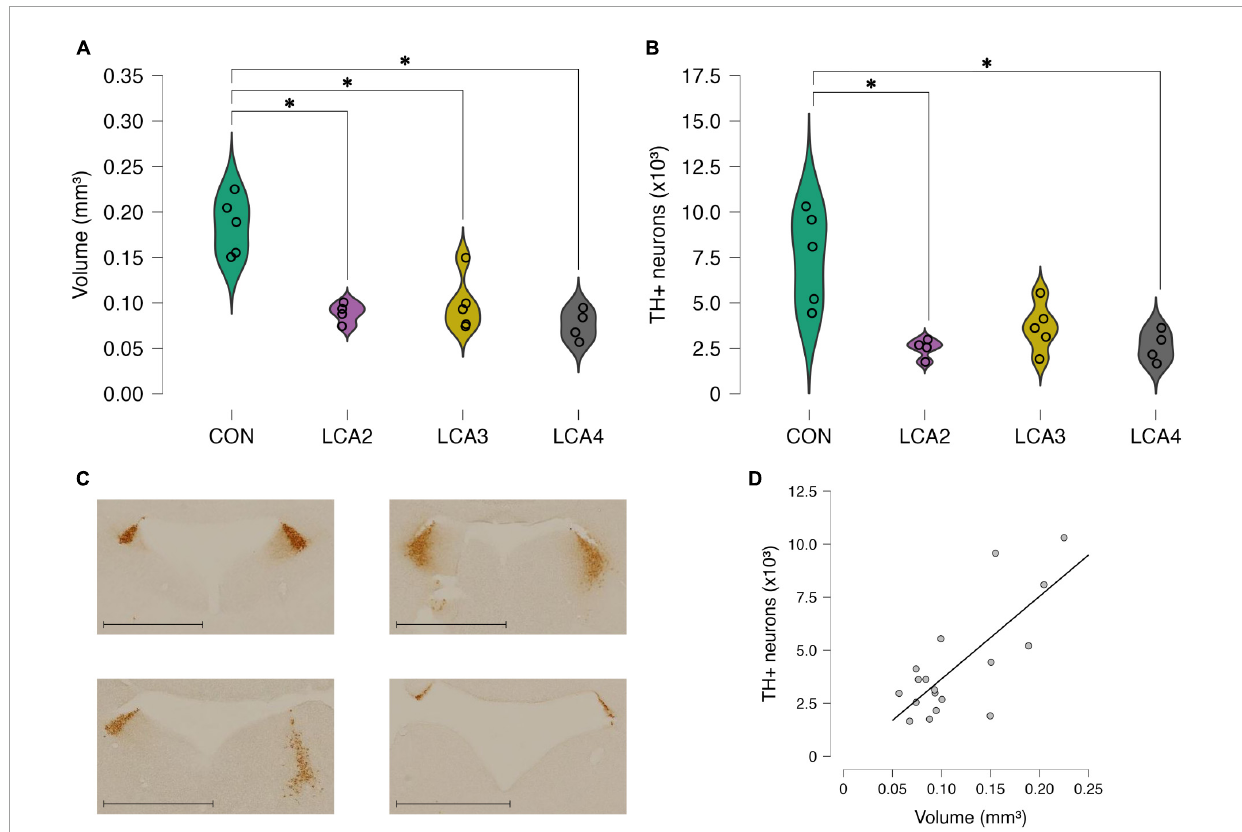
FIGURE2 Stereological results presented as the sum of both hemispheres. (A) The estimated LC volume of the individual observations and smoothed distribution curves of each group. A statistically significant reduced LC volume was observed in all LCA groups compared to the CON group. No statistically significant differences were observed between the LCA groups. Group means: CON 0.185 mm 3 [95% CI (0.157, 0.213), CV = 0.17], LCA2 = 0.089 mm 3 [95% CI (0.078, 0.100), CV = 0.13], LCA3 = 0.099 mm 3 [95% CI (0.072, 0.125), CV = 0.31], LCA4 = 0.076 mm 3 [95% CI (0.059, 0.092), CV = 0.22]. (B) The estimated TH+ neuron count in LC of the individual observation and smoothed distribution curve of each group. A statistically significant reduction in TH+ neuron count was observed in the LCA2 and LCA3 groups compared to the CON group, while no statistically significant differences were found when comparing CON and LCA3 and the LCA groups internally. Group means: CON = 7,522 neurons [95% CI (5238, 9807), CV = 0.62, CE = 0.13], LCA2 = 2,490 neurons [95% CI (1975, 3004), CV = 0.49, CE = 0.13], LCA3 = 3664 neurons [95% CI (2495, 4833), CV = 0.53, CE = 0.16], LCA4 = 2,601 neurons [95% CI (1749, 3453), CV = 0.52, CE = 0.16]. (C) Representative sections of the specificity of LC with TH immunostaining. The blank area is the fourth ventricle. Upper left = CON, upper right = LCA2, lower left = LCA3, lower right = LCA4. Scale bar = 1,000 µ m. (D) Correlation between LC volume and TH+ LC neuron count. A statistically significant correlation was found between the two parameters. CON = four saline injections ( n = 5), LCA2 = two DSP-4 injections ( n = 4), LCA3 = three DSP-4 injections ( n = 5), LCA4 = four DSP-4 injections ( n = 4). ∗ p <